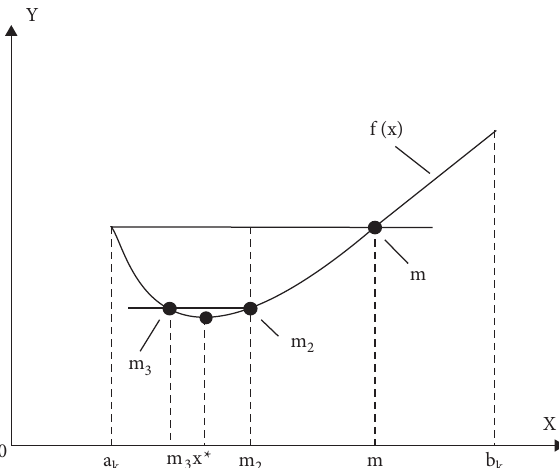
Figure 1: Schematic diagram of the new one-dimensional search